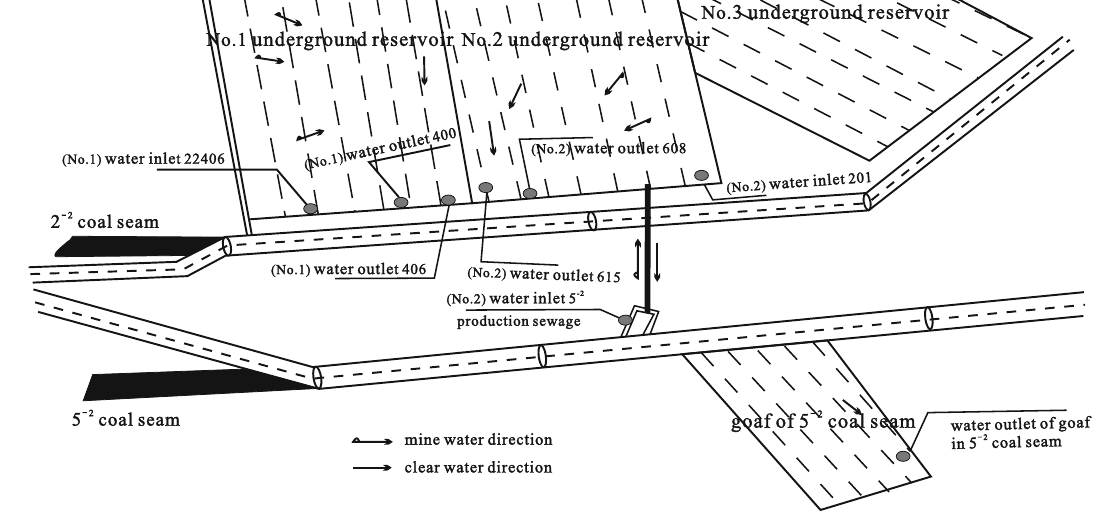
Fig. 1 Water sample collection location